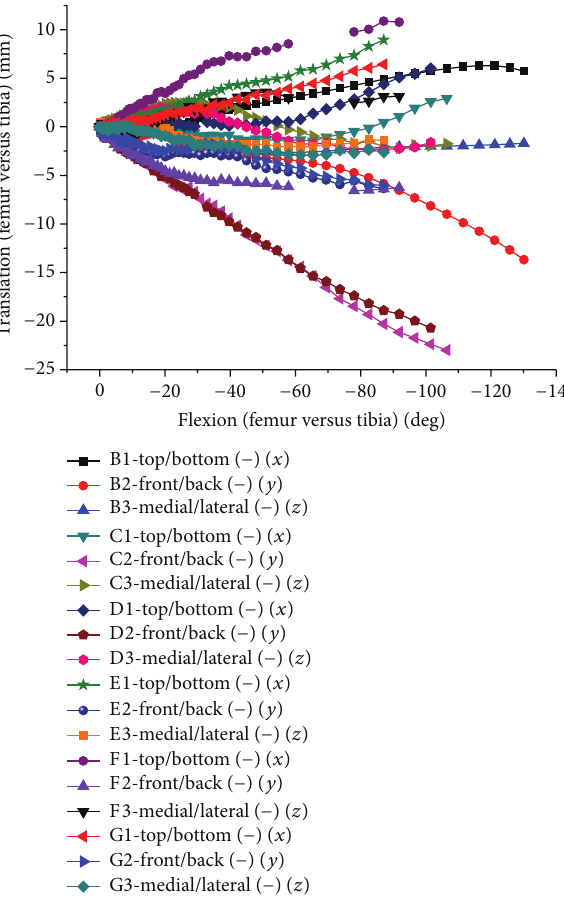
Figure 11: The relative translation of tibiofemoral joint in both test and